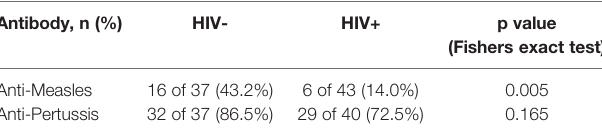
(Fishers exact test)